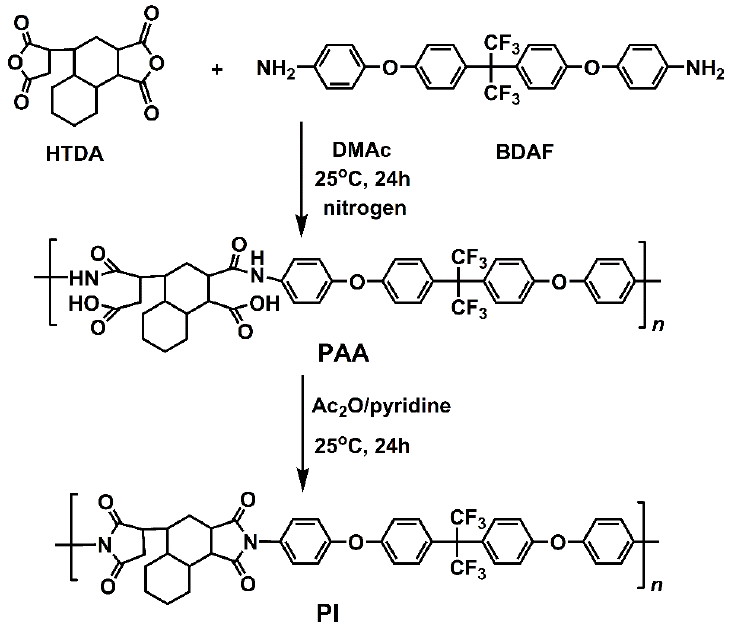
Figure 2. Synthesis of PI (HTDA-BDAF) resin. Table 2. Inherent viscosities, molecular weights, and solubility of PI